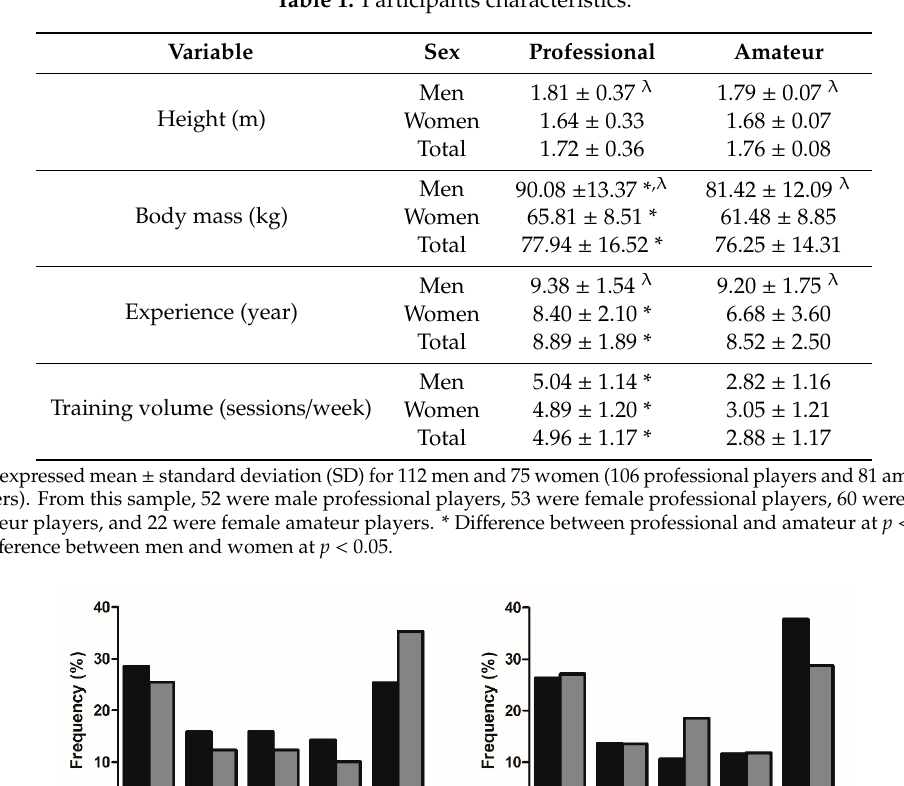
Table 1. Participants characteristics.